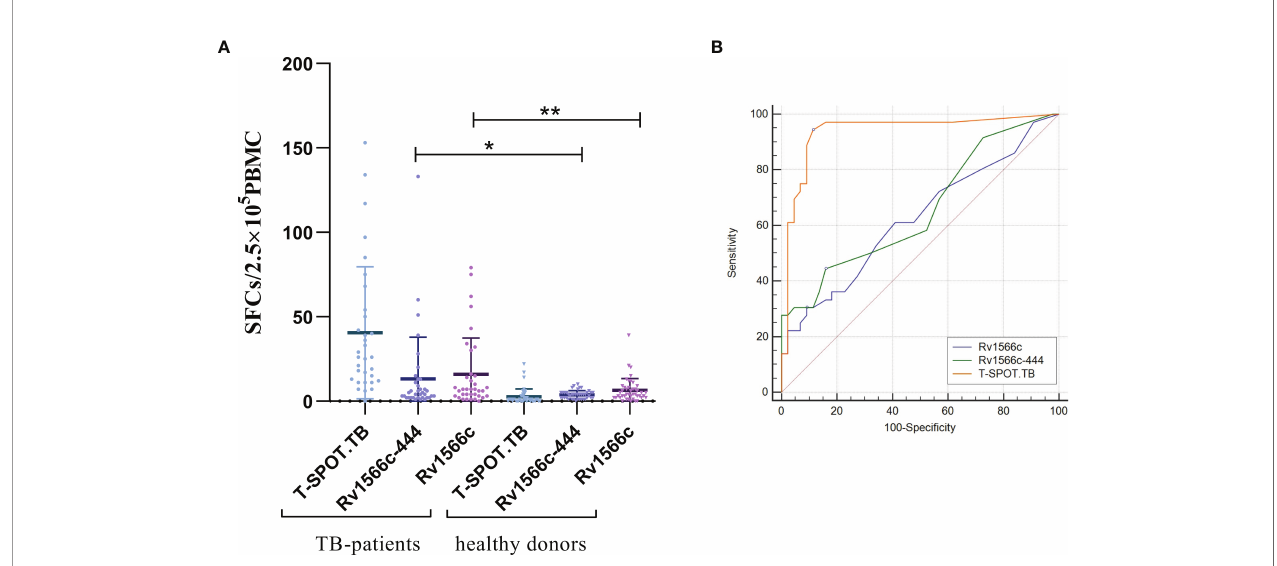
FIGURE 3 | Analysis of the IFN- g ELISpot response to the recombinant protein Rv1566c-444, Rv1566c in tuberculosis patients and healthy donors. (A) The difference of IFN- g SFCs in Rv1566c-444, Rv1566c, and T-SPOT. Each dot represents the SFCs of one patient or donor. The average response in each group is indicated by solid lines. The P-values of the differences in SFCs between the groups were determined by one-way ANOVA with Turkey ’ s multiple comparison tests (*p < 0.05, **p < 0.01). (B) ROC curves analysis of Rv1566c-444, Rv1566c, and cocktail peptides in T-SPOT kit for